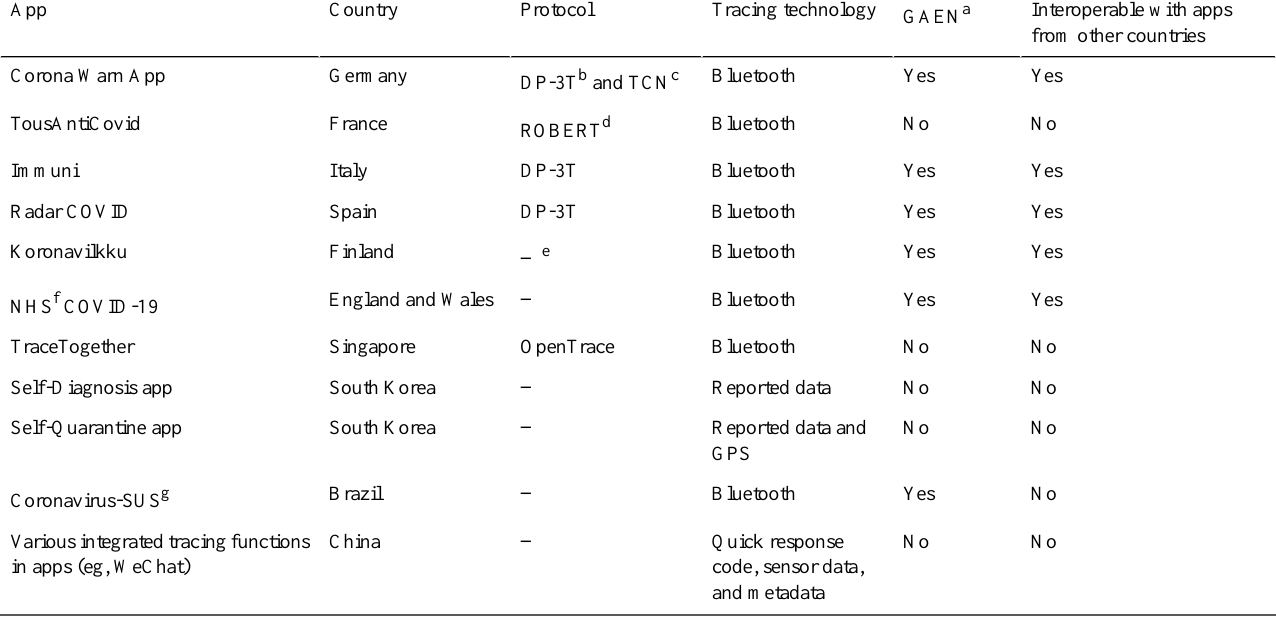
Table 2. Technical information of the apps.